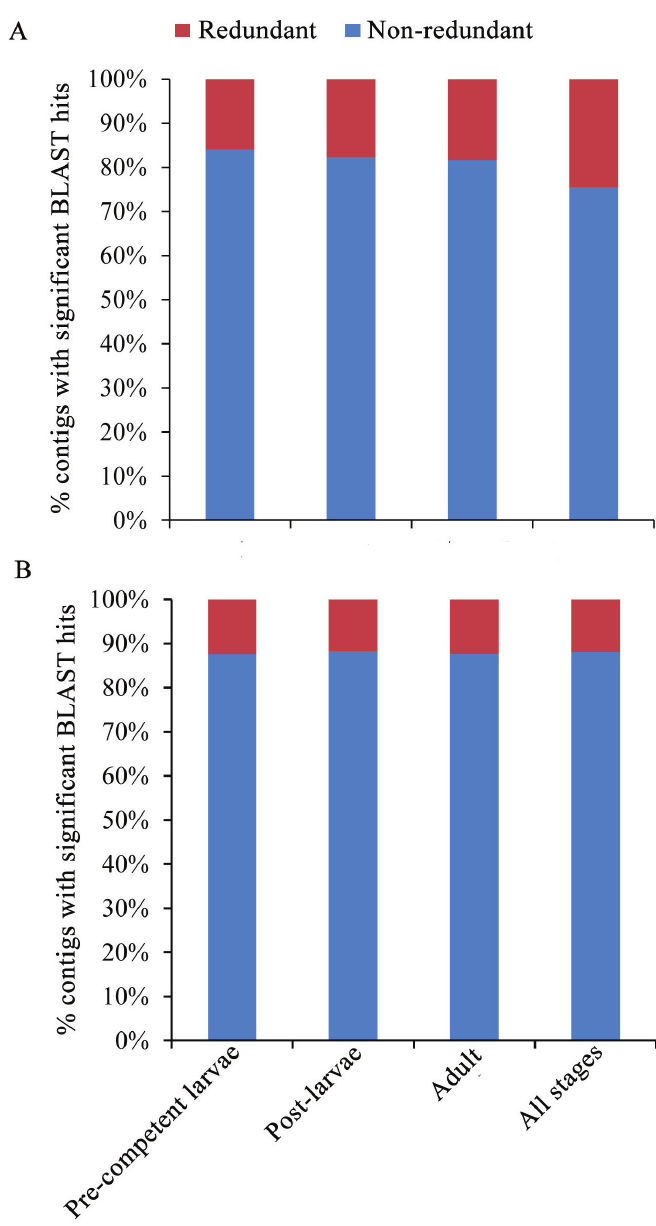
Figure 7. Estimates of redundancy for the four life cycle/all stages. ( A ) Redundancy as broadly defined as the frequency of multiple contigs with overlapping and/or non-overlapping BLAST hits to the same gene; ( B ) Redundancy as narrowly defined with only the subset of multiple non-overlapping contigs. The total numbers of contigs with significant BLAST hits are provided for the four life cycle/all stages in Figure